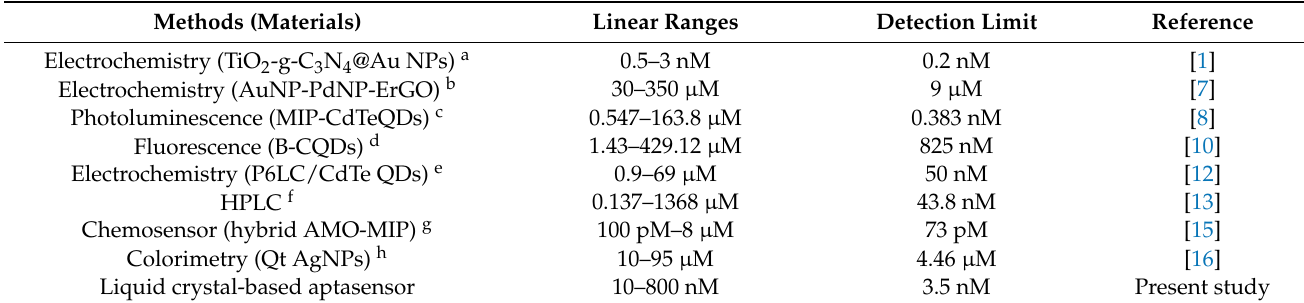
Figure 5. Calibration curve of the average gray-scale intensities (GIs) of the POM images vs. the concentration of AMX (y is the average GI of the POM image, x is the concentration of AMX, R 2 is the linear correlation coefficient) ( n = 3). Table 1. Comparison with various methods for the detection of